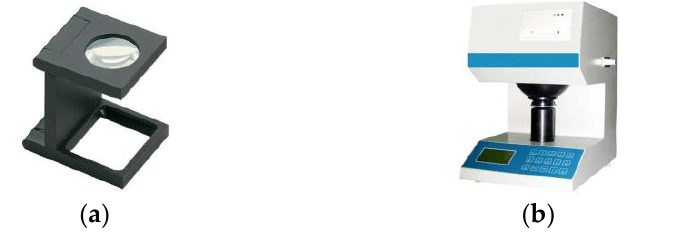
Figure 1. Instruments for manual detection. ( a ) Eight times magnifying glass. ( b ) Chromaticity measuring instrument.